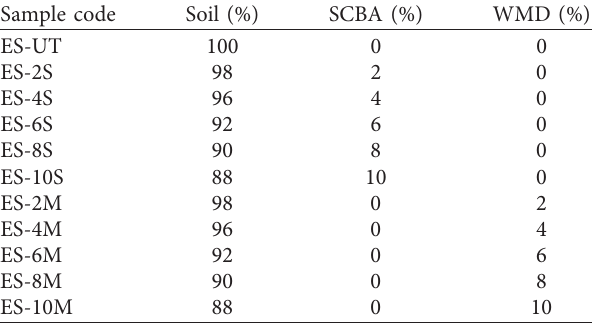
Table 3: Sample nomenclature with expansive soil, SCBA, and WMD